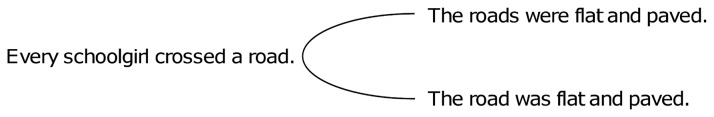
Example of an ambiguous pre-test item in Dwivedi et al. (2010).Participants were instructed to circle the continuation sentence (e.g. The
roads
were
flat and paved or The
road
was
flat and paved) that best fit with the first sentence (e.g. Every schoolgirl crossed a road).